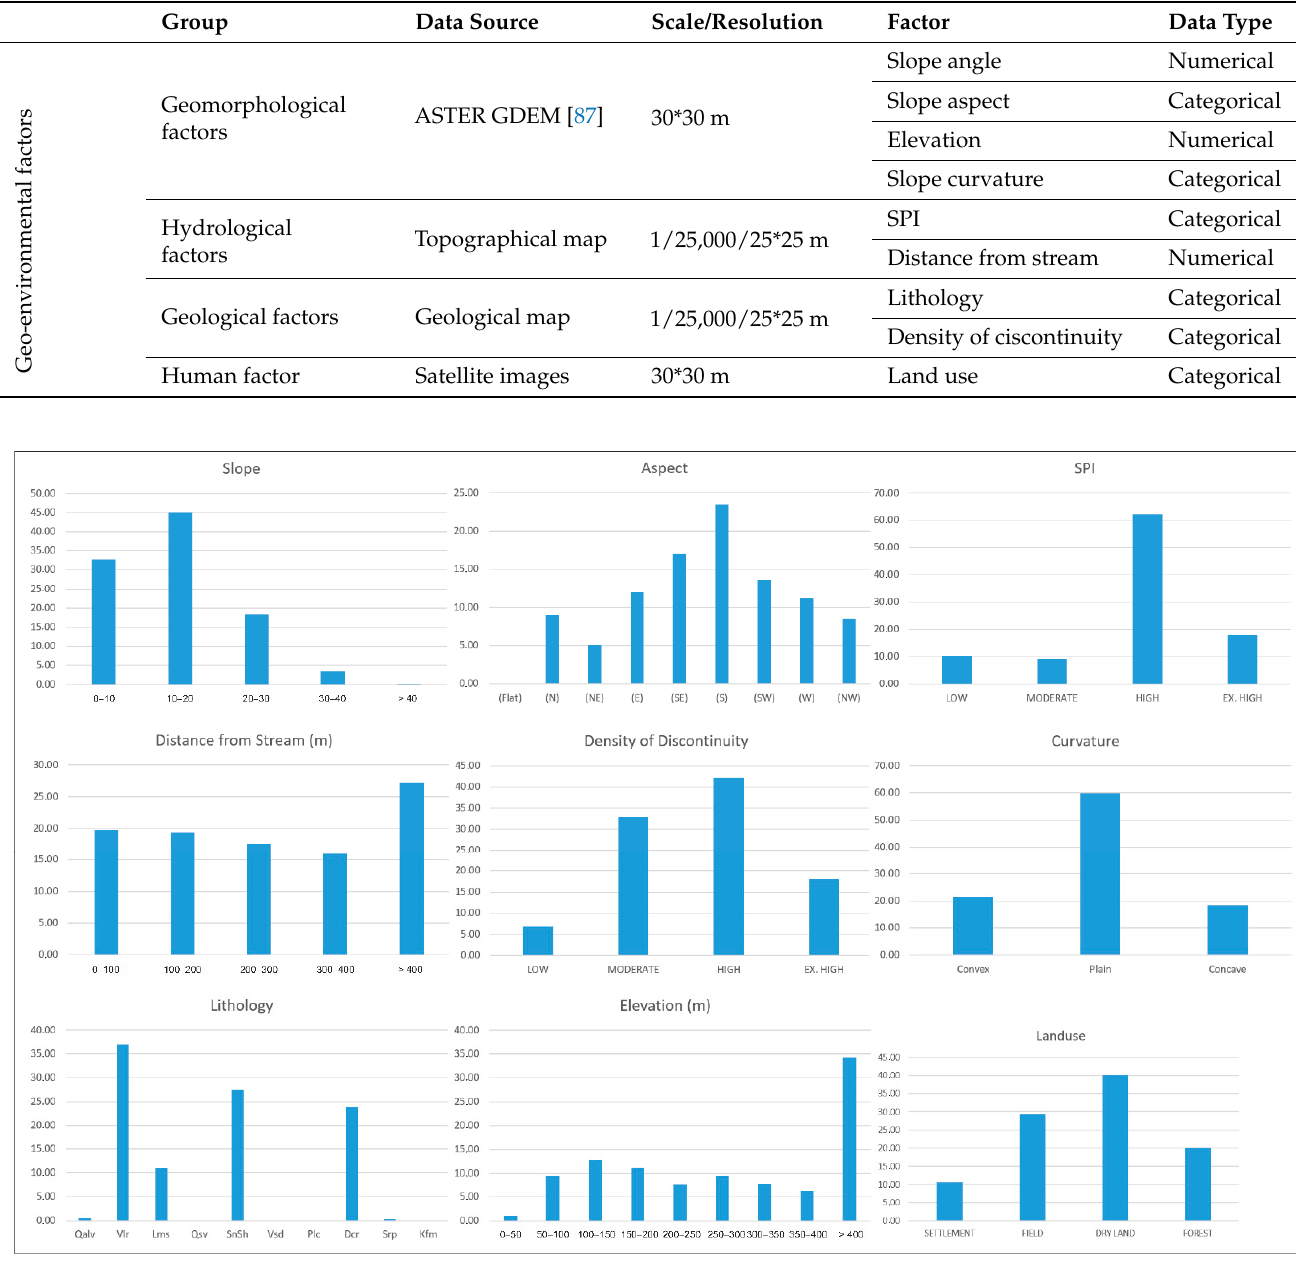
Figure 4. Geo-environmental factors and associated percentages of landslides for evaluation of landslide susceptibility.